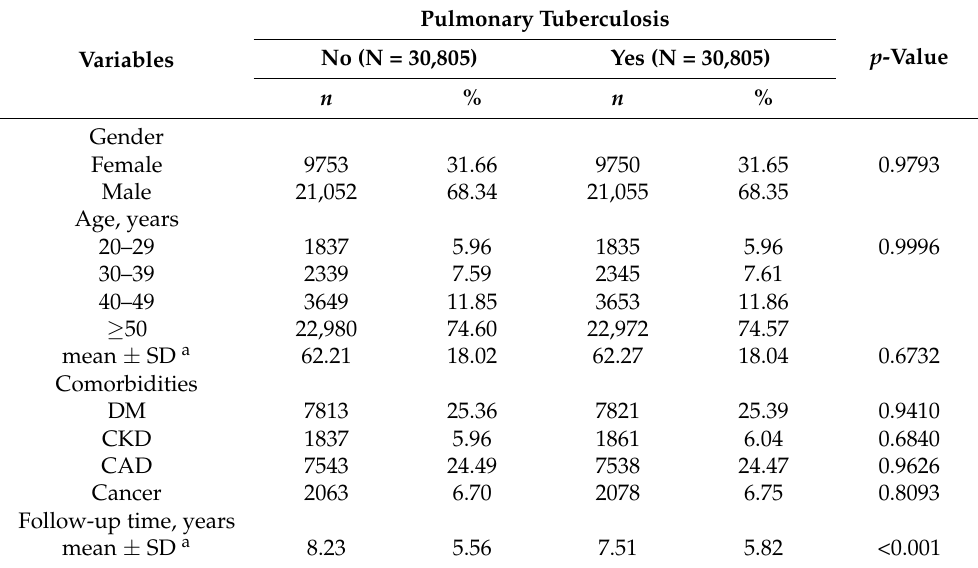
Table 1. Baseline characteristics for individuals with and without pulmonary